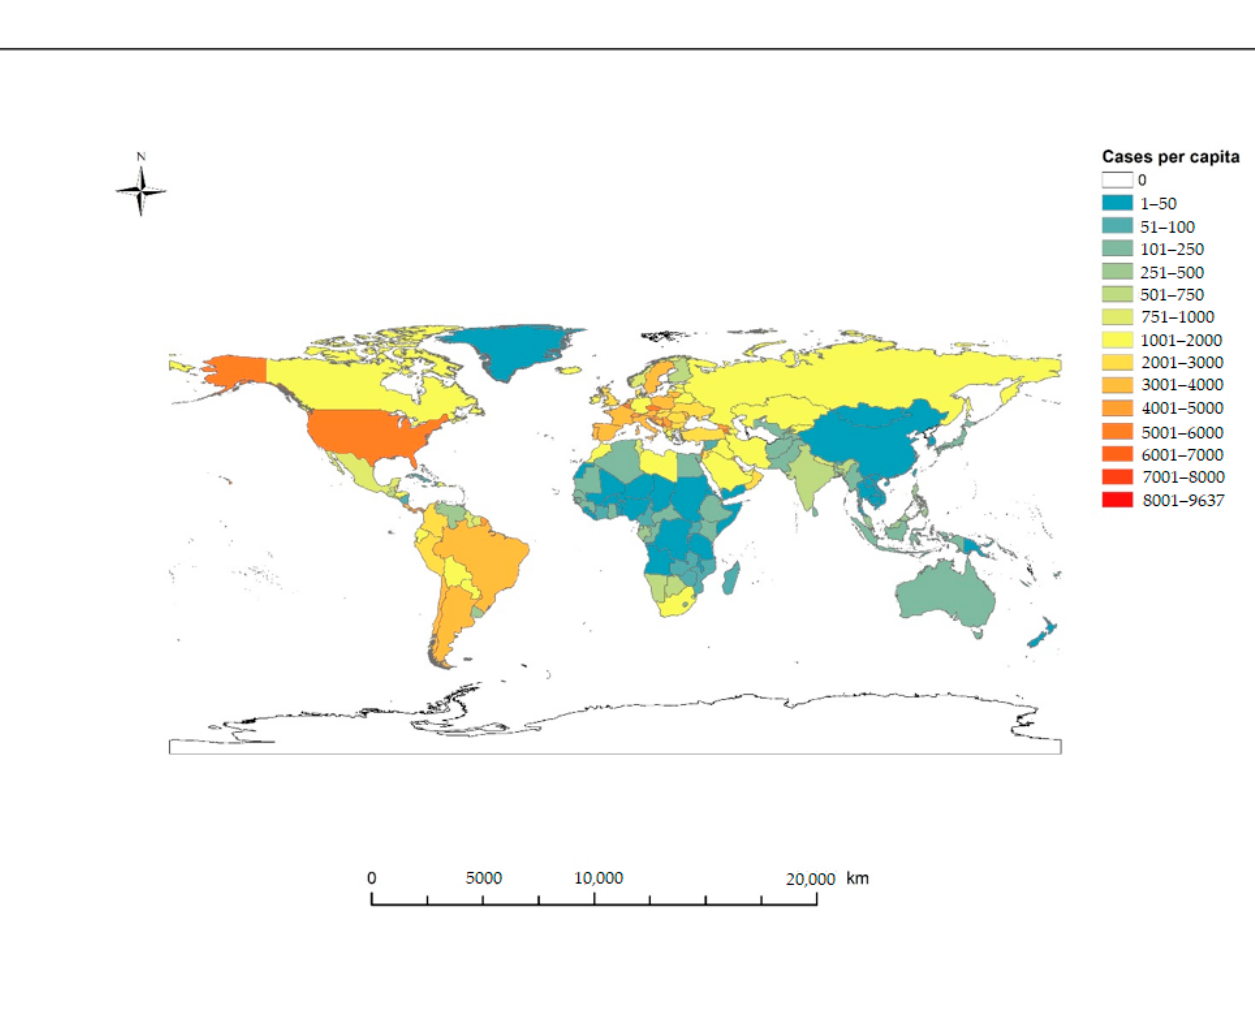
Figure 1. Global distribution of COVID-19 cases per capita as of 16 December 2020 (cases per 100000 population).